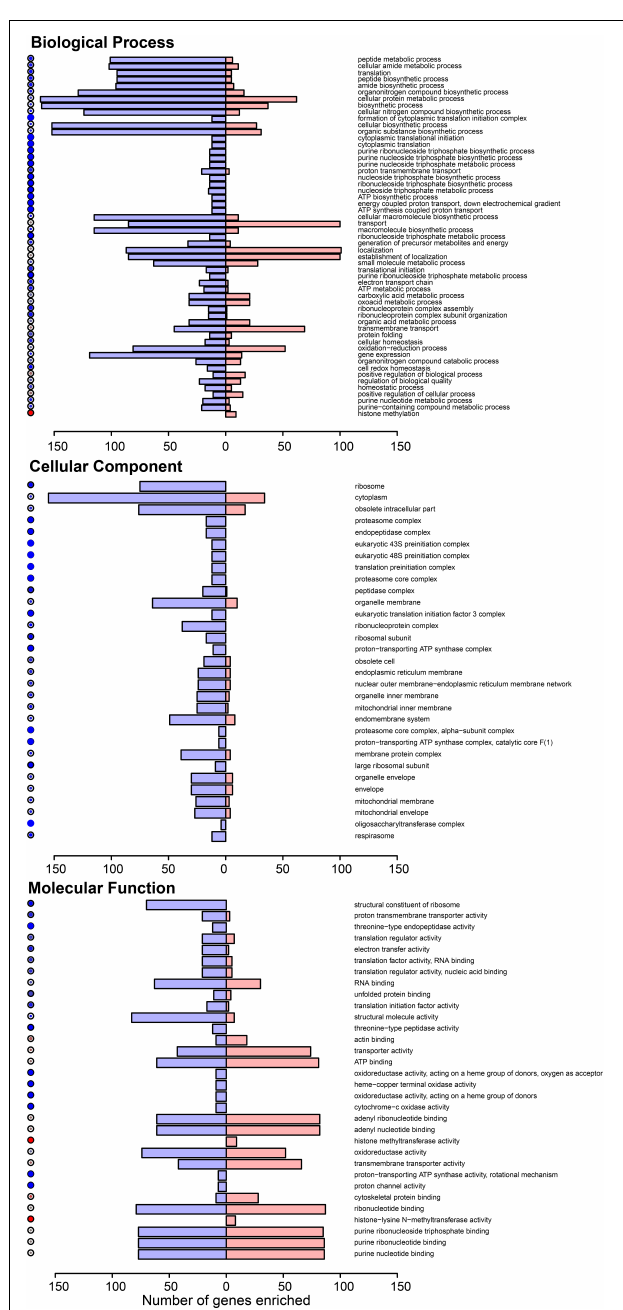
FIGURE 3 | Gene ontology (GO) of the differentially expressed genes in A. aegypti ovaries transcriptomes 3 days after DENV-2 blood feeding vs. mock blood feeding. The color dots to the left of each category shows the dominating proportion of genes either downregulated (blue) or upregulated (red) within the GO